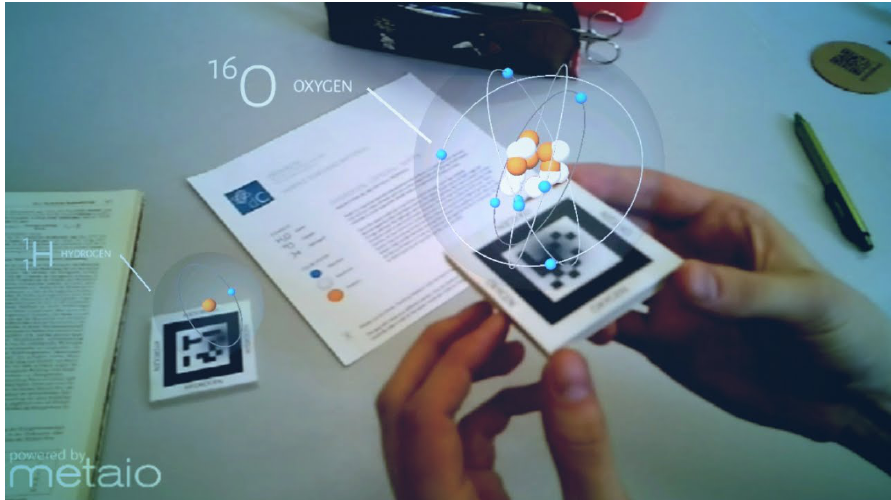
Figure 4. 2D bar-codes are used to display Hydrogen and Oxygen elements in